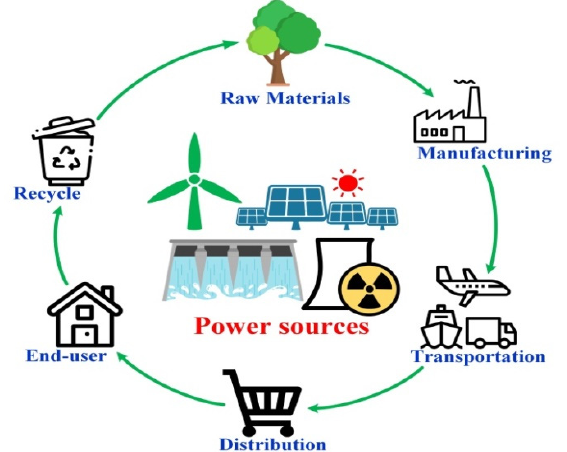
Figure 2. Principle of life cycle analysis.